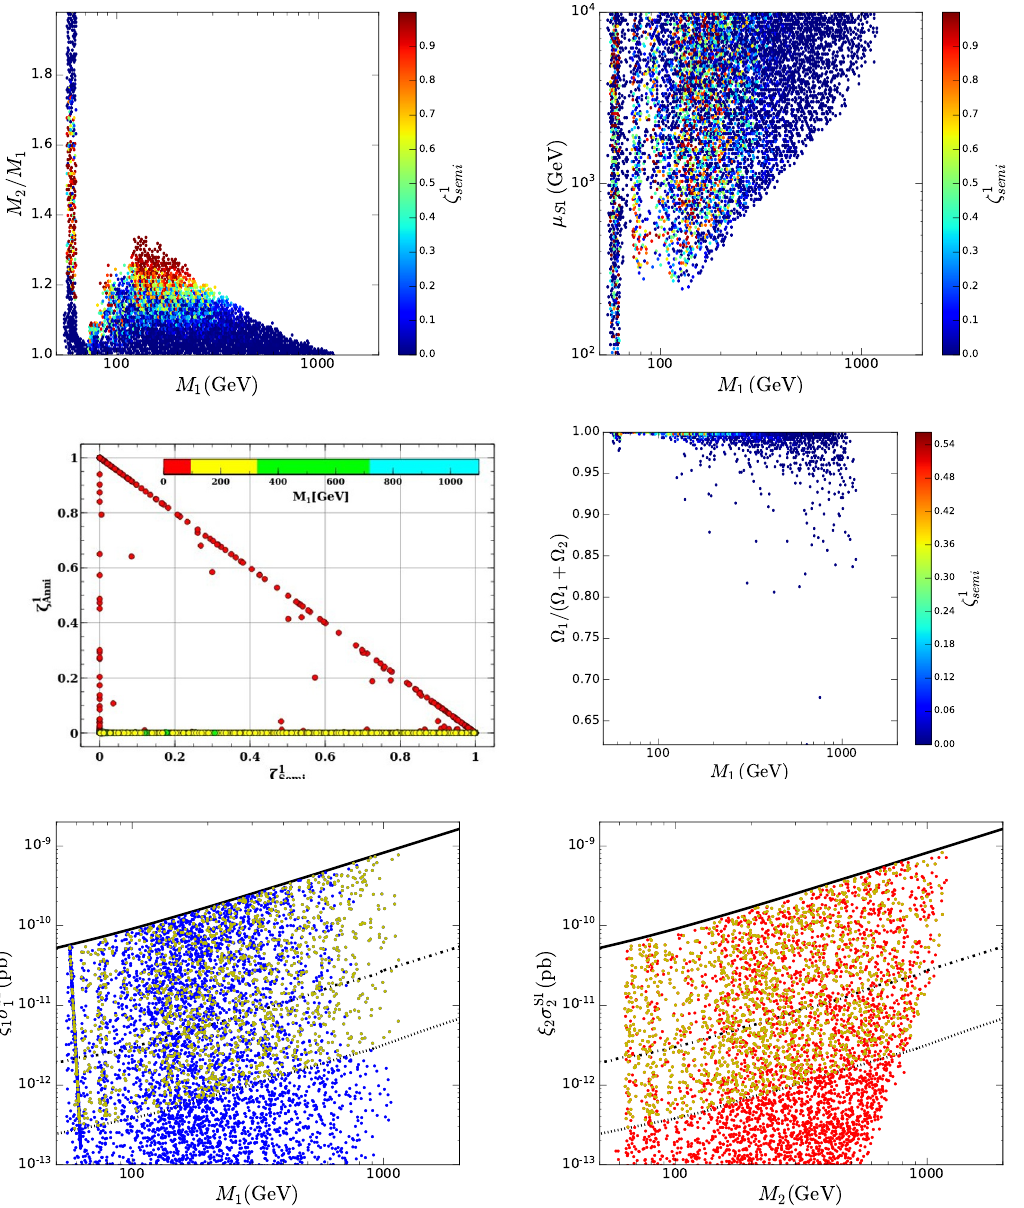
Figure 13 . Results for the scan with 0 : 1 (cid:20) (cid:22) S 2 (cid:20) 10 TeV, (cid:22) S 1 = 0 and (cid:21) 3 i = (cid:21) 412 = 0. Top panels: the viable parameter space; center panels: annihilation fraction vs semi-annihilation fraction and relative contribution of (cid:10) 1 to (cid:10) DM ; bottom panels: SI cross-sections scaled by (cid:24) i where the solid line is the upper limit set by XENON1T collaboration [25] and the dot-dashed (dotted) line is the projected sensitivity of LZ [26] (DARWIN [27])